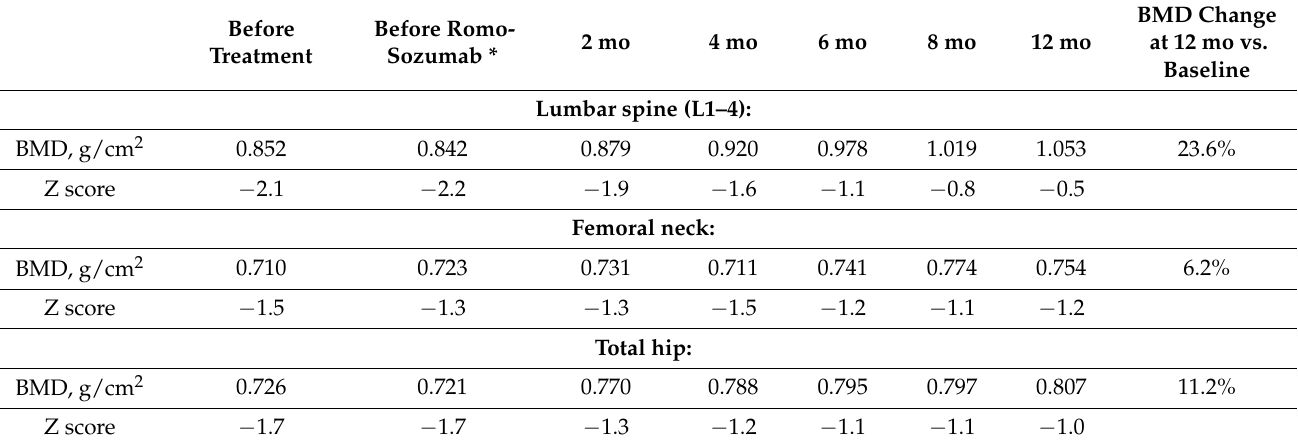
Table 2. Bone mineral density values before and after romosozumab